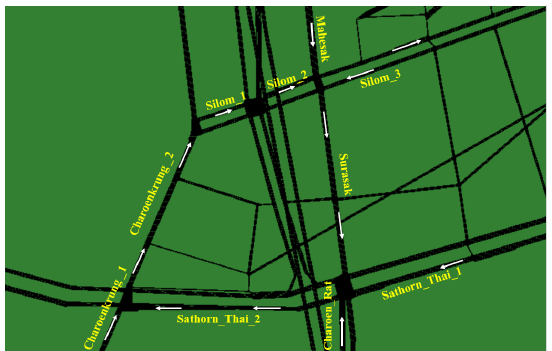
Figure 4. Links in the Sathorn critical